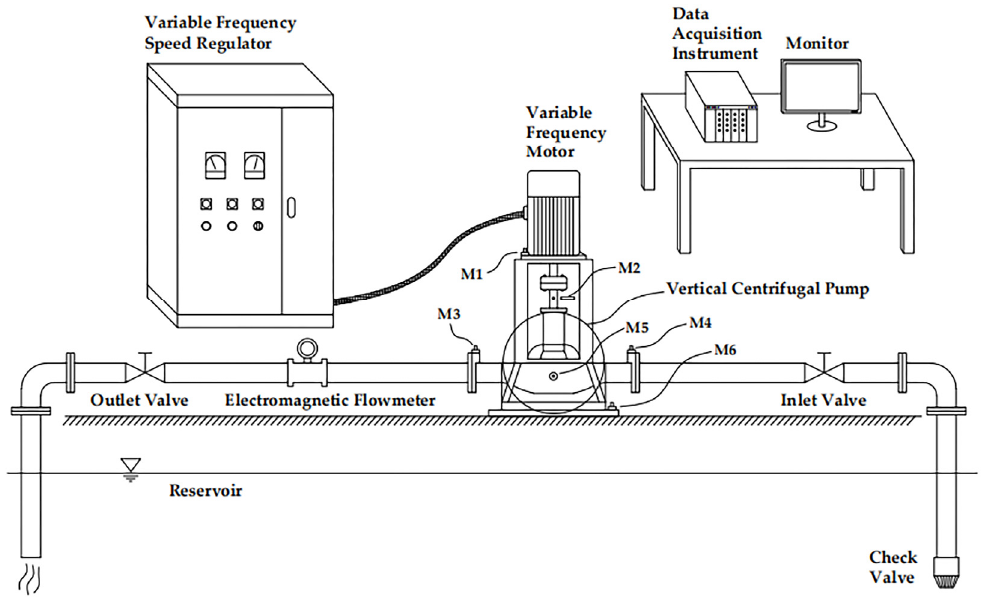
Figure 1. Schematic diagram of vertical centrifugal pump fault simulation test system .